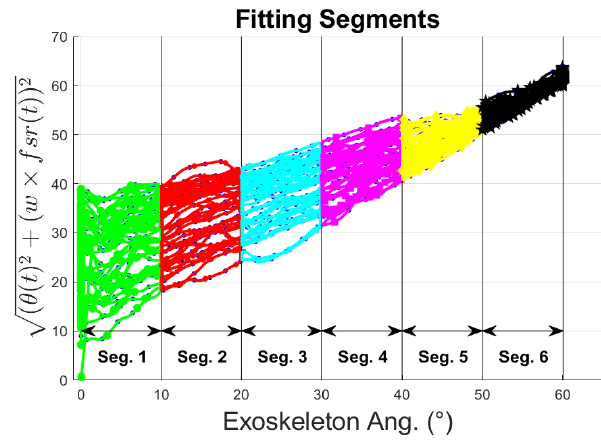
Figure 10. Segments to perform curve fitting model analysis. The mean curve of the distribution is determined by approximating each segment to a linear line, ˆ z i = a i × θ ( t ) + b i . The parameters of the line are determined by minimizing the residual sum of squares (RSS), Equation (2), between the training data and the predicted value, least-square linear regression.